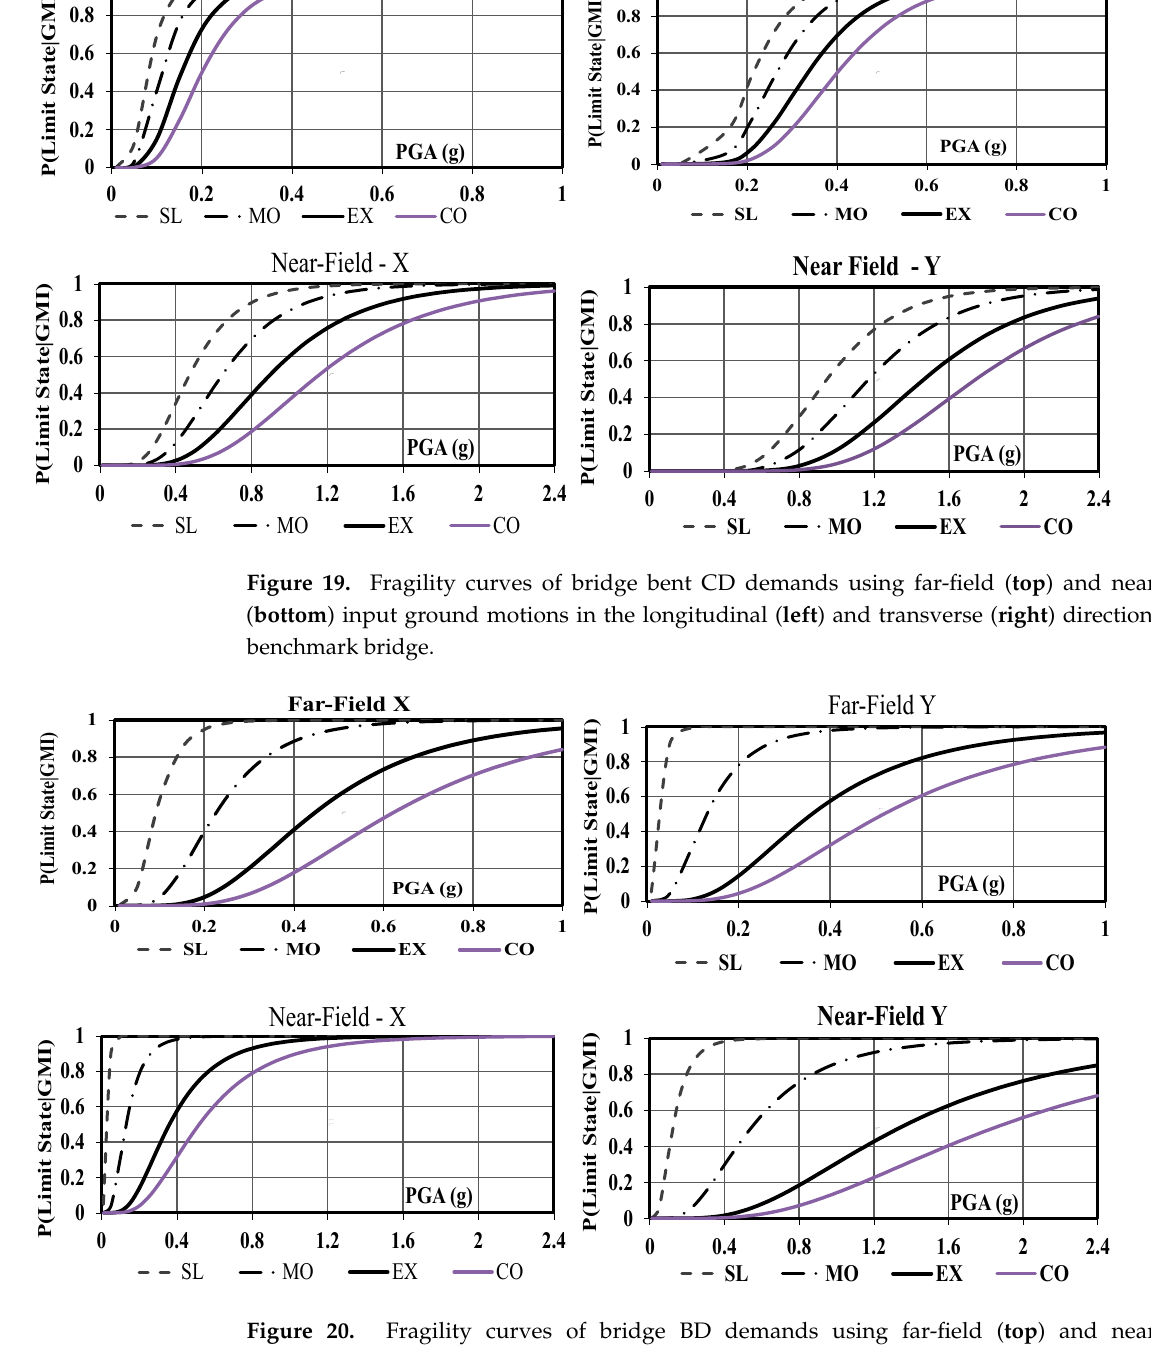
Figure 20. Fragility curves of bridge BD demands using far-field ( top ) and near-source ( bottom ) input ground motions in the longitudinal ( left ) and transverse ( right ) directions of the benchmark bridge.